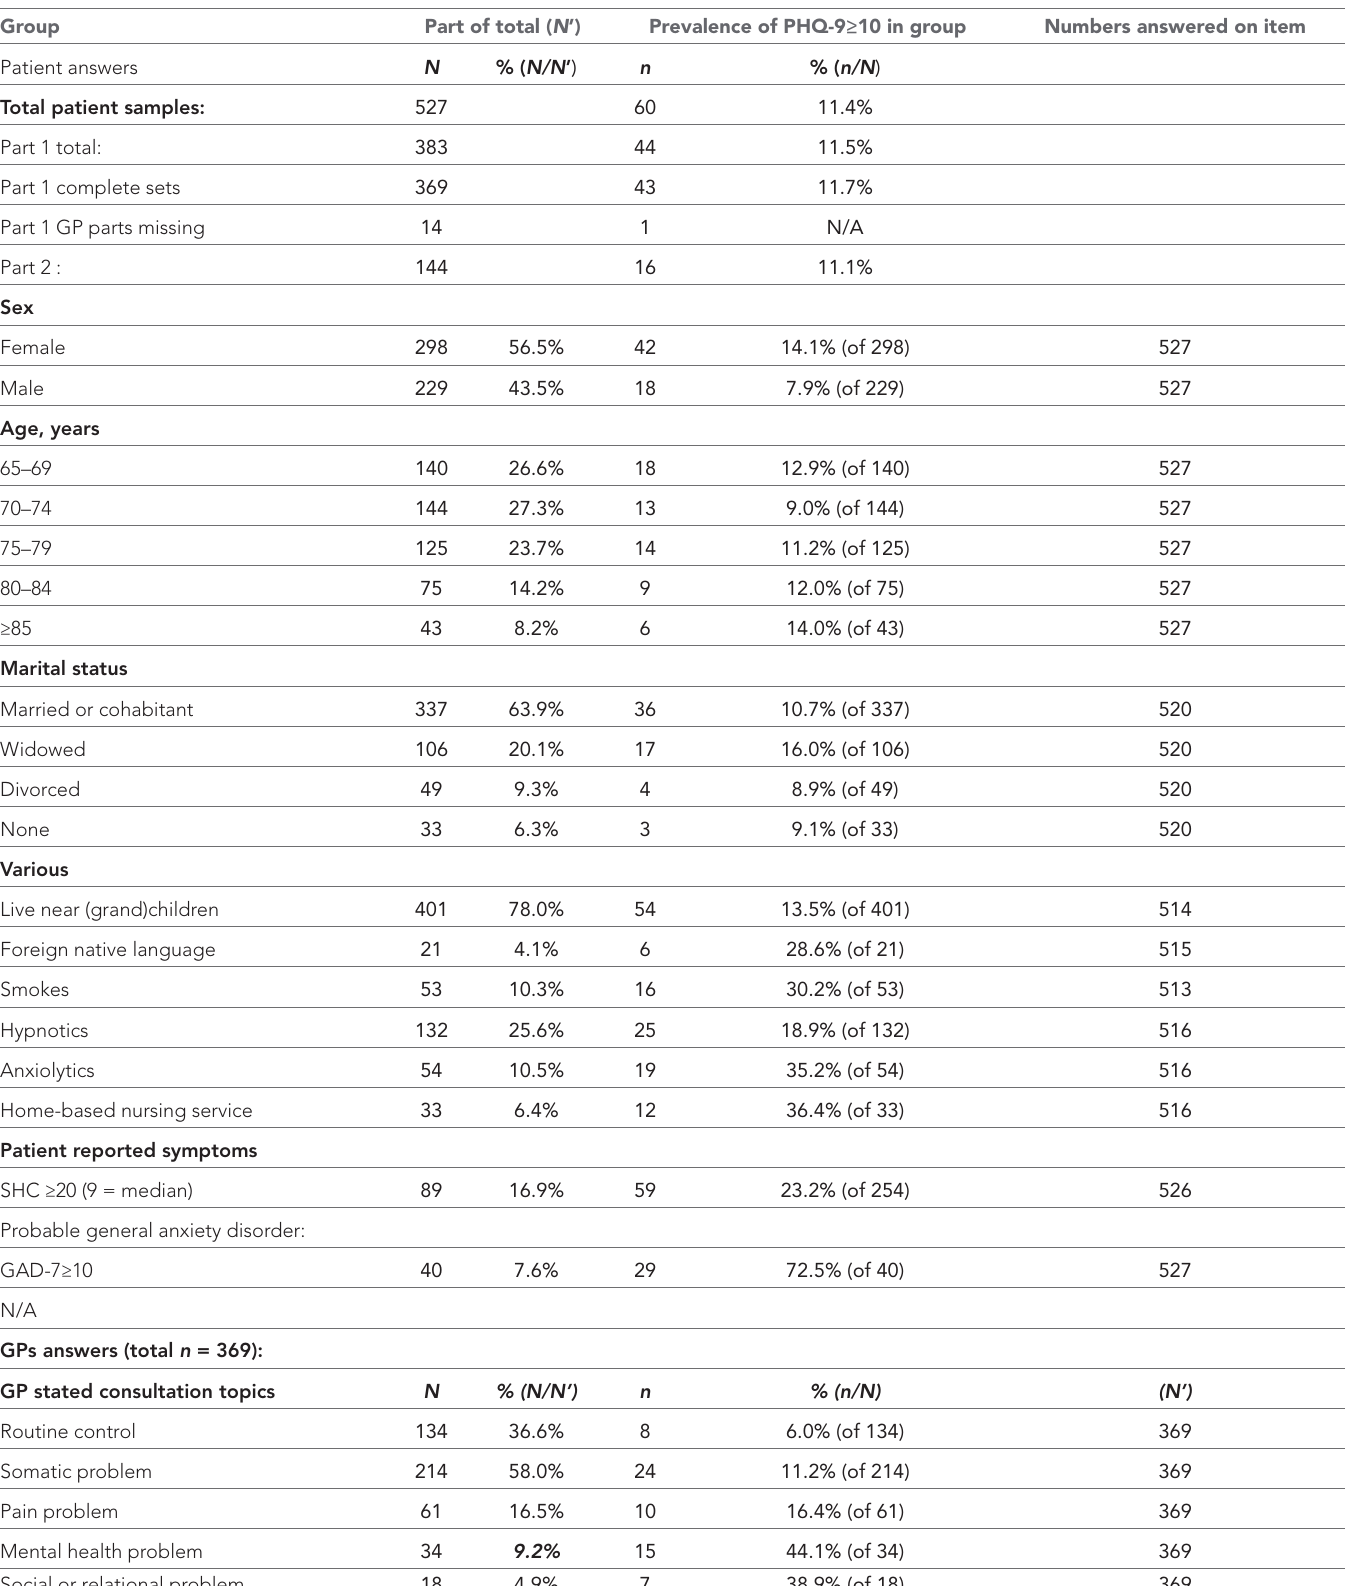
Table 1 Patient characteristics, and prevalence of moderate- to- severe depressive symptoms Group Part of total ( N ’) Prevalence of PHQ- 9≥10 in group Numbers answered on